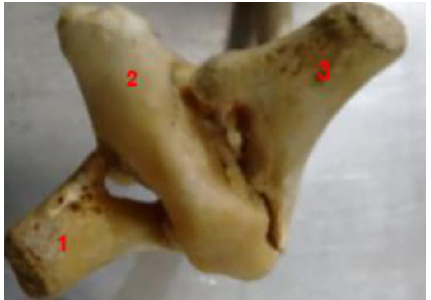
Figure 7. Limb after skin removal, covered with fibrous connective tissue. The root is formed by (1) head of the radius; (2) humerus; and (3) olecranon.